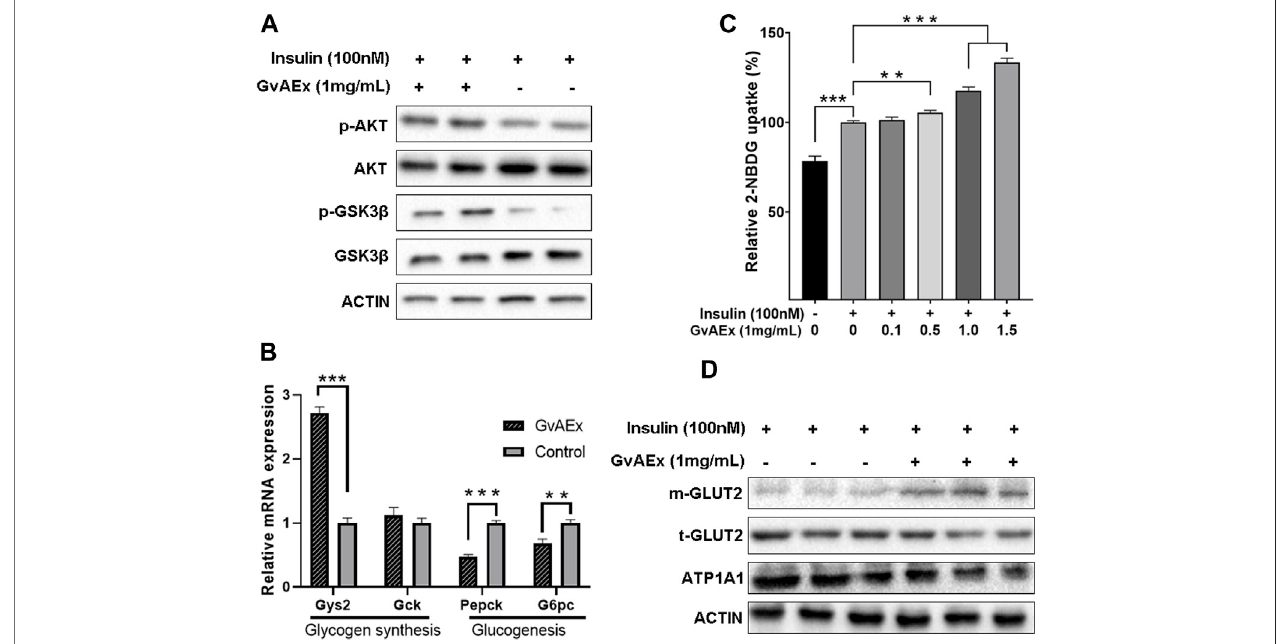
FIGURE 4 | GvAEx enhances insulin sensitivity and glucose uptake in hepatocytes. (A) Western blot analysis of insulin signaling-related molecules in HepIR cells with or without GvAEx treatment. (B) Relative mRNA expression levels of genes involved in glycogen synthesis and gluconeogenesis in HepIR cells treated with or withoutGvAEx( n =4). (C) EffectsofGvAExonglucose(2-NBDG)uptakeofinsulin-resistantHepIRcells( n =6). (D) :WesternblotanalysisoftotalandmembraneGLUT2. p * < 0.05, ** p < 0.01, *** p <